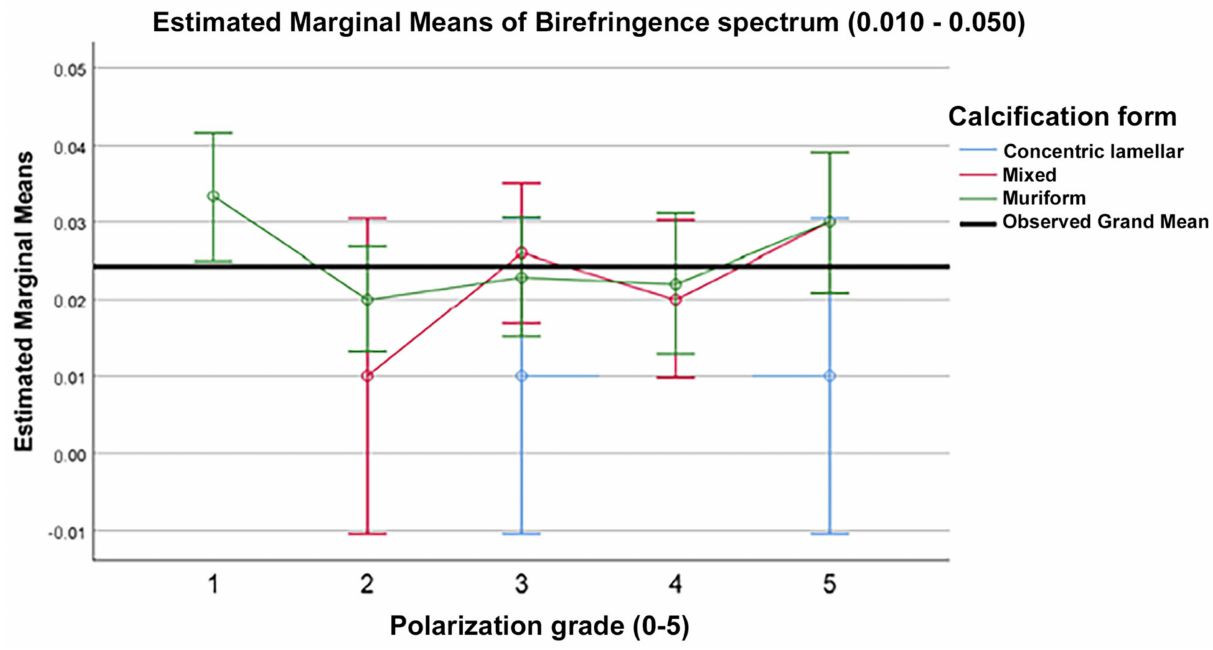
Figure 5. Estimated marginal means of the birefringence spectrum based on calcification form, polarization grade, and their